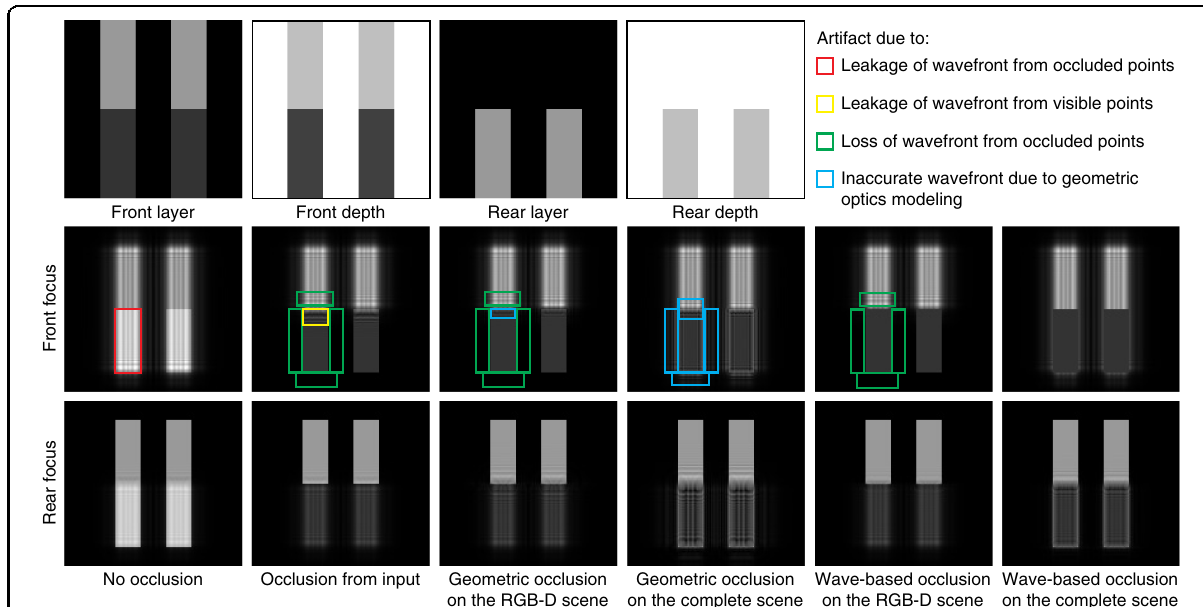
Fig. 9 Methods comparison for occlusion modeling. The top 4 images constitute a 2-layer LDI that completely depicts the test scene. Different types of artifacts are only marked for the front focus